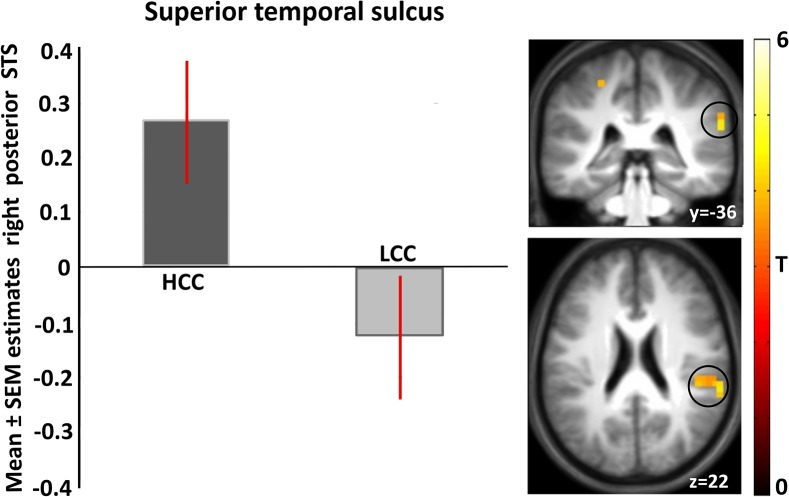
Mean parameter estimates, peak coordinate (62. -36. 22) of the brain region with stronger activation in response to HCC versus LCC.Shown is a T-map for visualization thresholded at T = 3.5 p<0.001 uncorrected for multiple comparisons, superimposed on the mean anatomical image of all subjects (MNI-space).